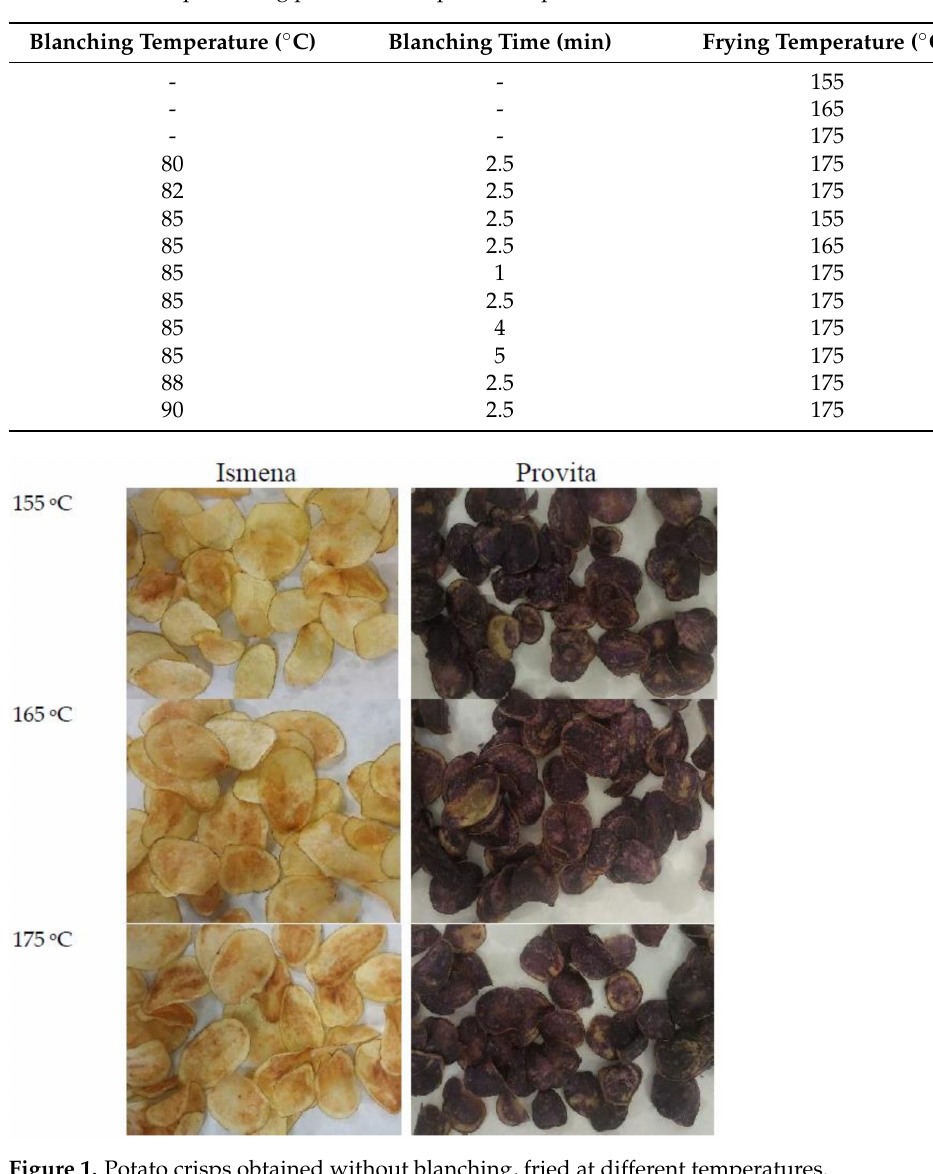
Table 1. Thermal processing parameters of potato crisps.